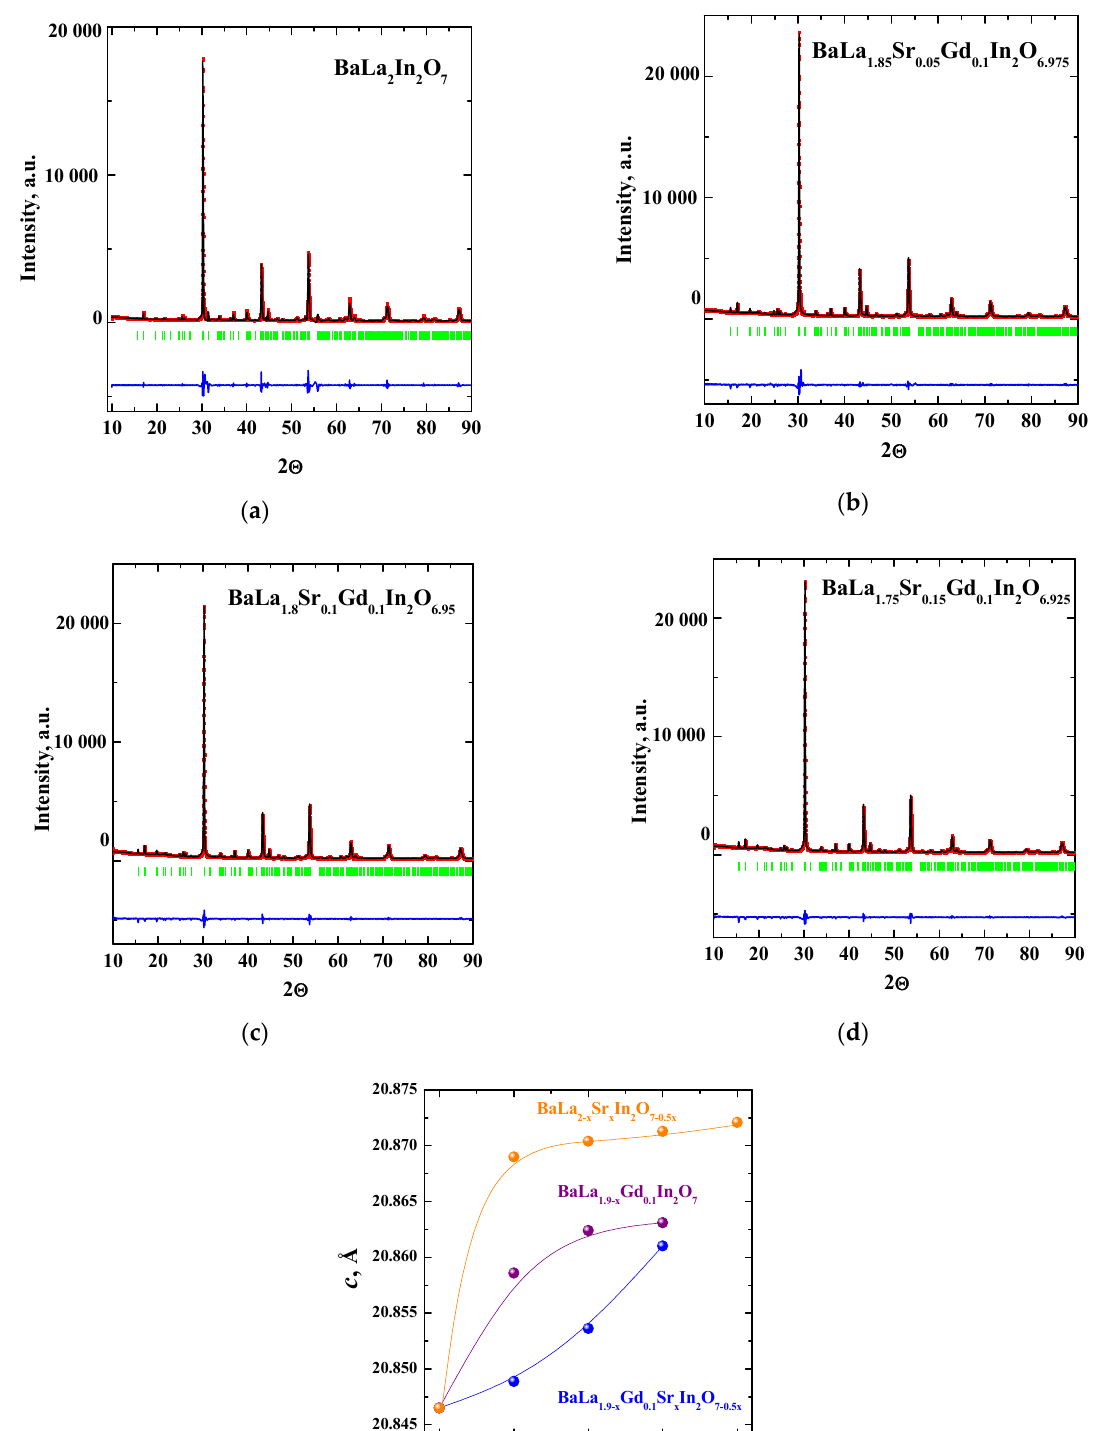
Figure 1. The results of XRD investigations (red dots are experimental data, black line is calculated pattern, blue line is the difference curve, green symbols are calculated peak positions) for the compositions BaLa 2 In 2 O 7 ( a ), BaLa 1.85 Sr 0.05 Gd 0.1 In 2 O 6.975 ( b ), BaLa 1.8 Sr 0.1 Gd 0.1 In 2 O 6.95 ( c ), BaLa 1.75 Sr 0.15 Gd 0.1 In 2 O 6.925 ( d ), and the concentration dependencies of the lattice parameter c for the solid solutions BaLa 1.9− x Sr x Gd 0.1 In 2 O 7−0.5 x (blue line), BaLa 2− x Sr x In 2 O 7−0.5 x [38] (orange line) and BaLa 2− x Gd x In 2 O 7 [39] (violet line) ( e ).